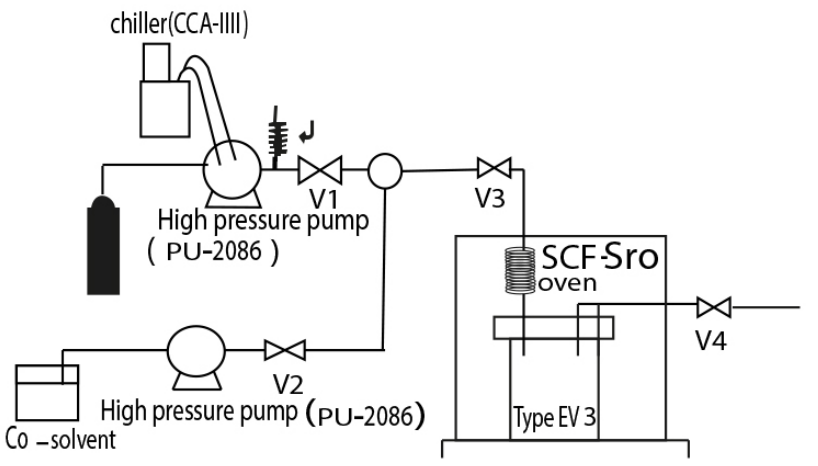
Figure 2. Supercritical CO